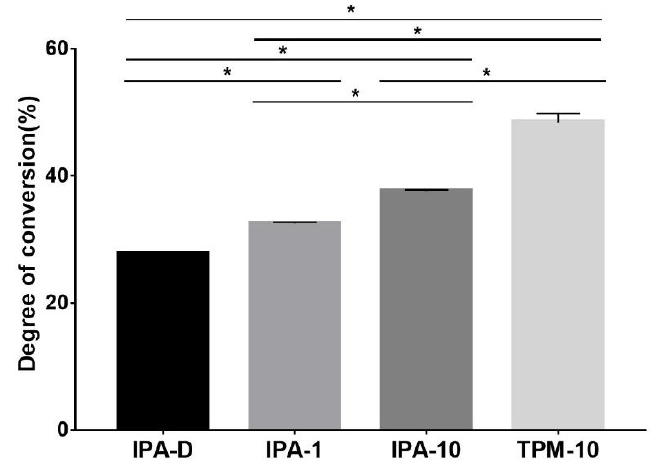
Figure 6. Degree of conversion according to different washing conditions: * significant difference at p < 0.05.